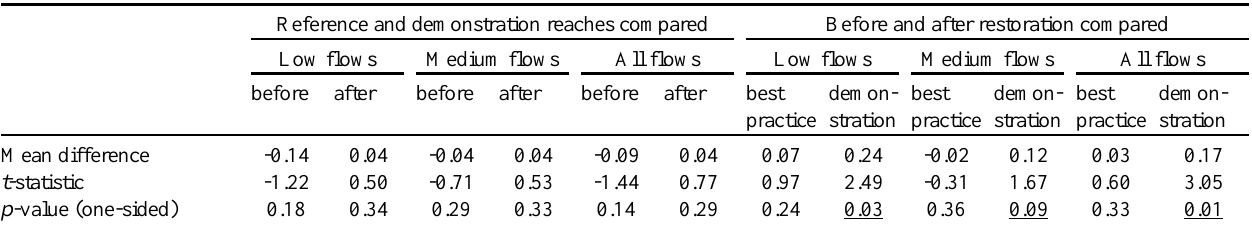
Table 2 . Pairwise comparisons of coefficient of variation (CV) for velocity within a reach per measurement period for each flow